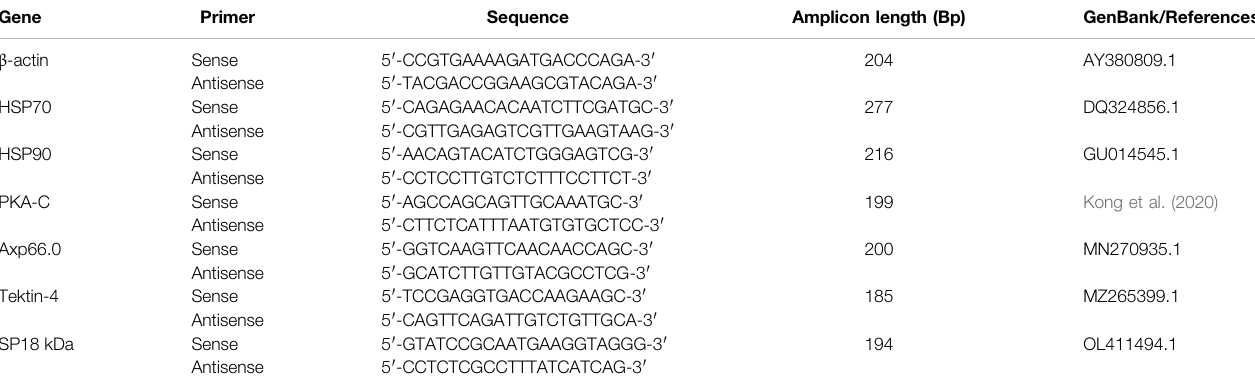
TABLE 1 | List of primers used for qRT-PCR quanti fi cation of genes in